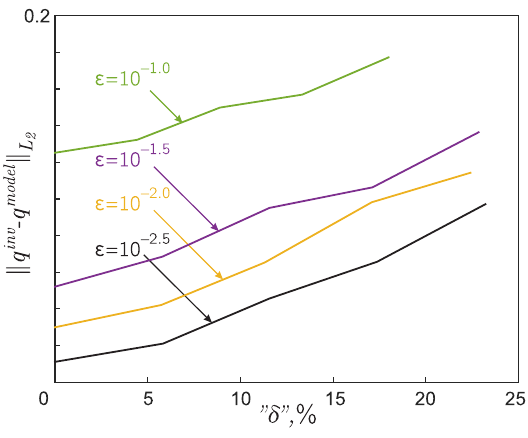
Figure 5. The norm of the residual versus the noise level δ of the inverse problem data for various ε .